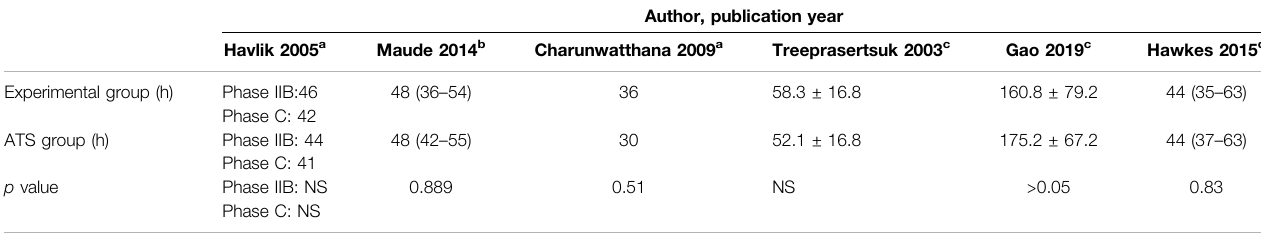
TABLE 3 | PCT levels of ATS monotherapy group and ATS+adjuvant therapy group in patients with severe